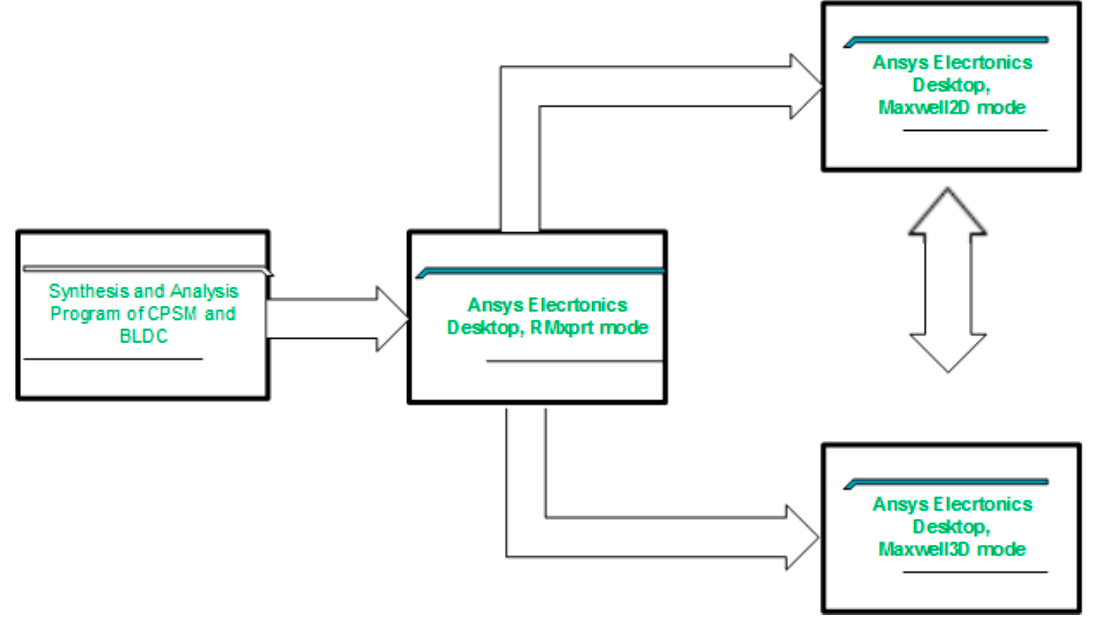
Figure 2. Design scheme of a Claw-Pole Synchronous Machine (CPSM) design.